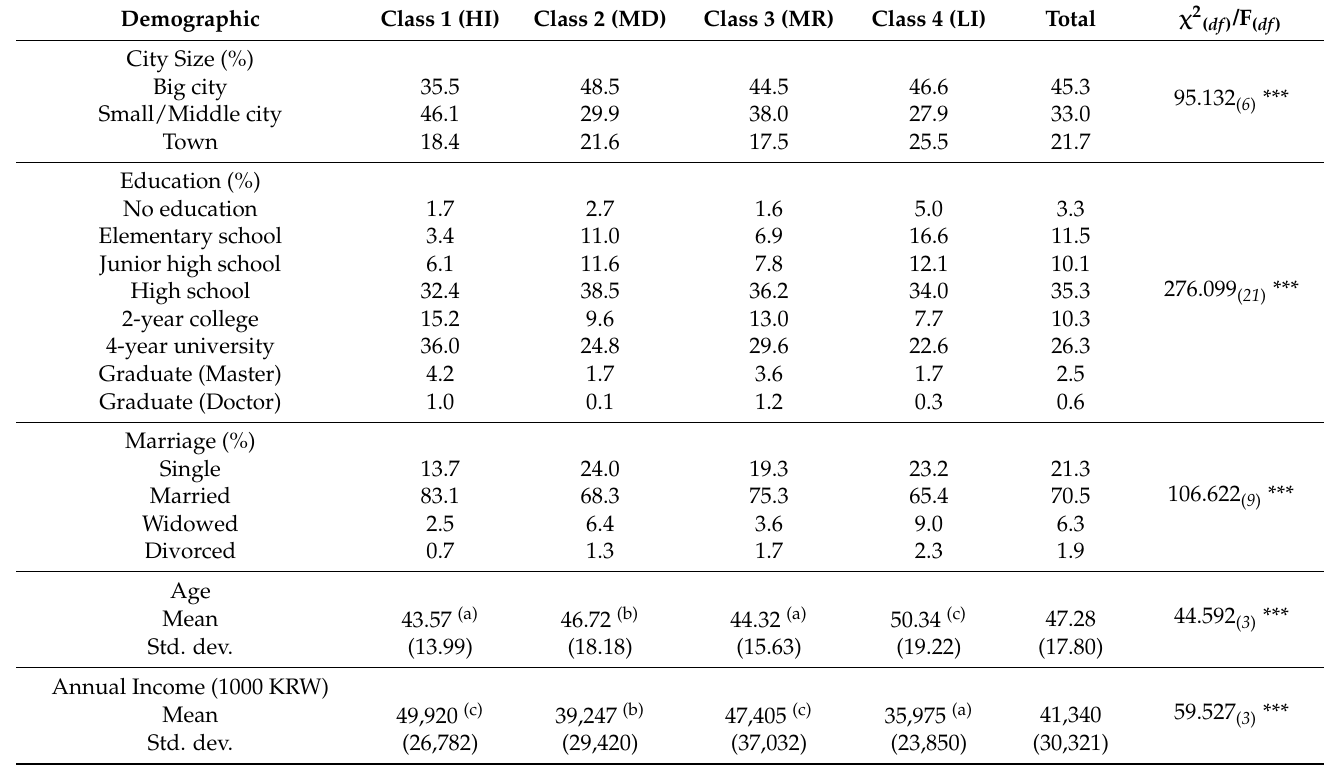
Table 5. Differences in demographic characteristics between trajectories.